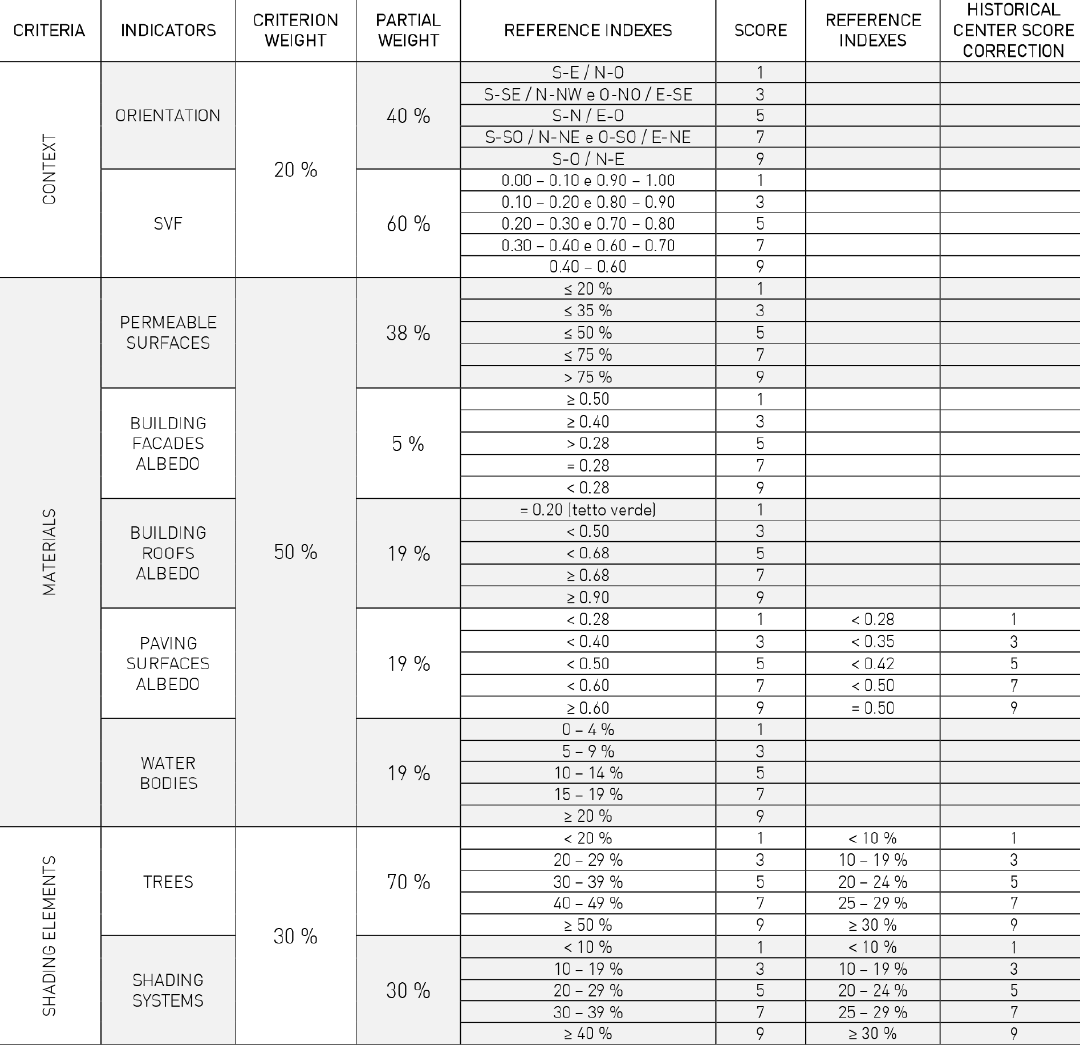
Figure A16. Summary of CADI-BE indicators.